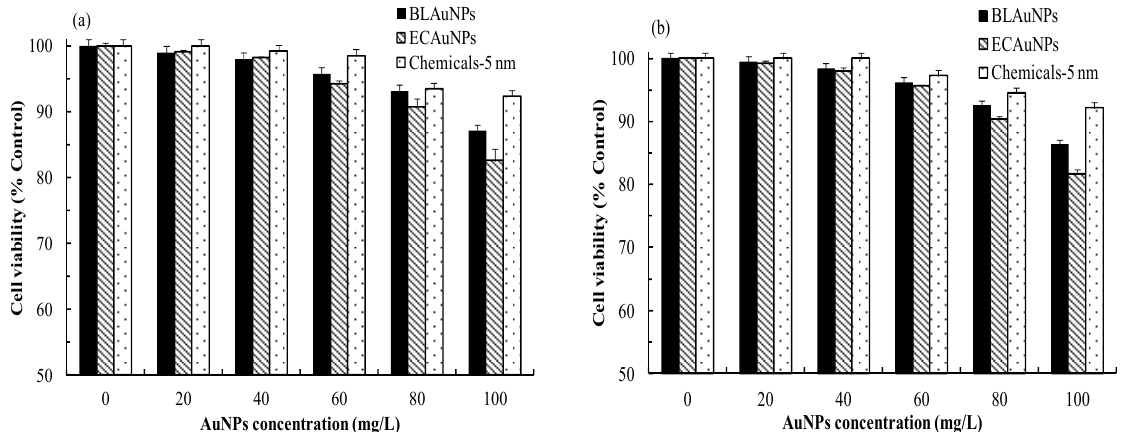
Figure 5. Cell viability of ( a ) HEMn cells and ( b ) CCD966SK cells treated by BLAuNPs, ECAuNPs, and Chemicals-5 nm at various concentrations after 72 h treatments.